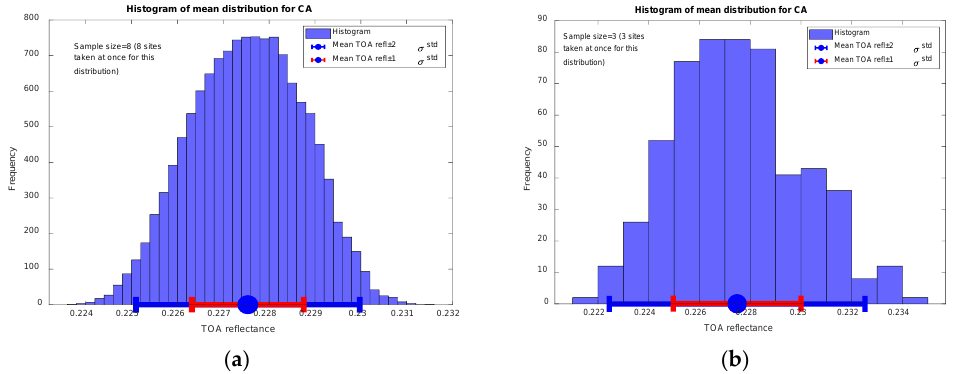
Figure 8. Histogram of the mean distribution of CA band when ( a ) eight distinct sites were considered at once (Left) and ( b ) three distinct sites were considered at once (Right).